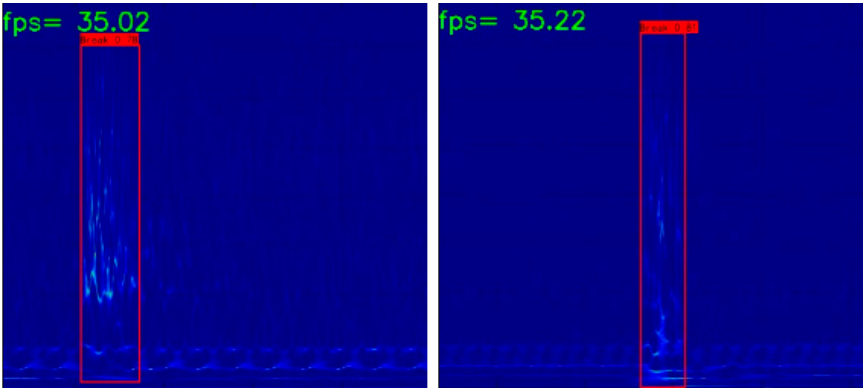
Figure 14. Examples of wire break detection results after fusing.